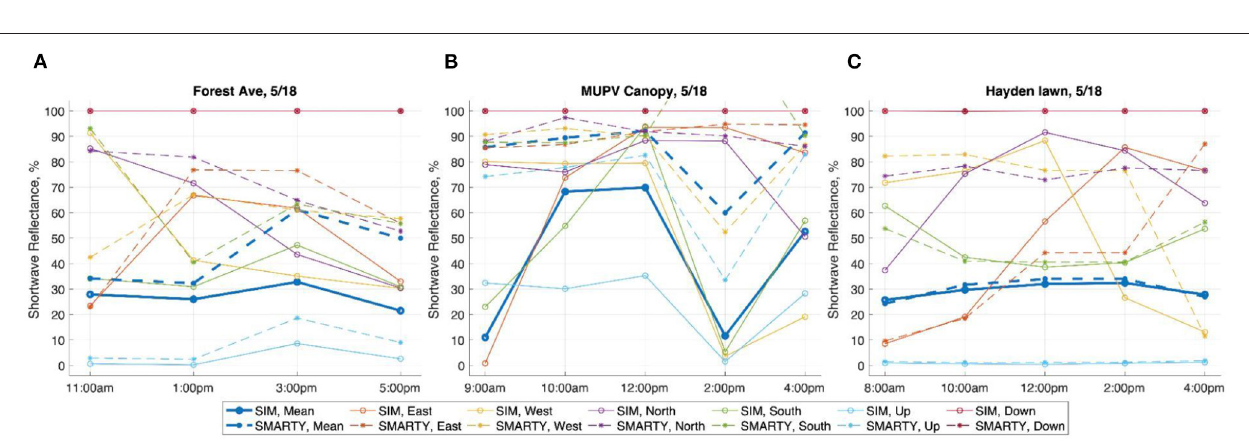
FIGURE 11 | Reflected shortwave variation across time and planar direction at Forest Ave (A) , MUPV (B) , and Hayden Lawn (C) . Solid lines are produced from the simulation data, and dashed lines are produced from the ratio of reflected ground to direct sky measurements taken from the SMaRT-SL sensor.